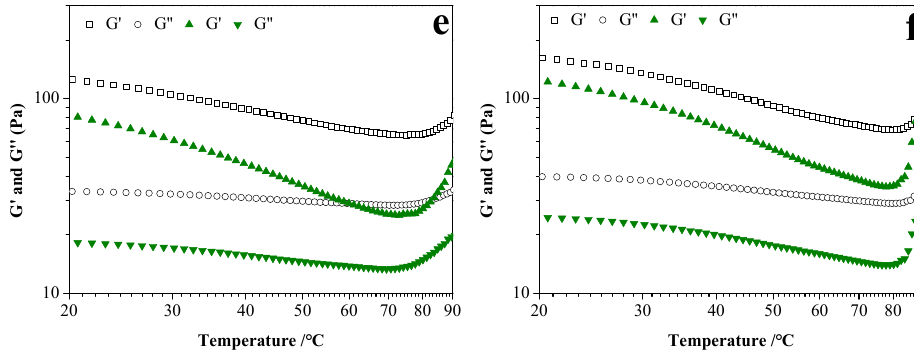
Figure 7. Temperature dependence of G ′ and G ″ moduli of RBOB-FG emulsion-filled gel during cooling (solid markers) and heating (open markers) ramps. FG hydrogel (0.2% FG) ( a ); RBOB-FG emulsion-filled gel (0.2% FG) ( b ); FG hydrogel (0.8% FG) ( c ); RBOB-FG emulsion-filled gel (0.8% FG) ( d ); FG hydrogel (2.0% FG) ( e ); RBOB-FG emulsion-filled gel (2.0% FG) ( f ).